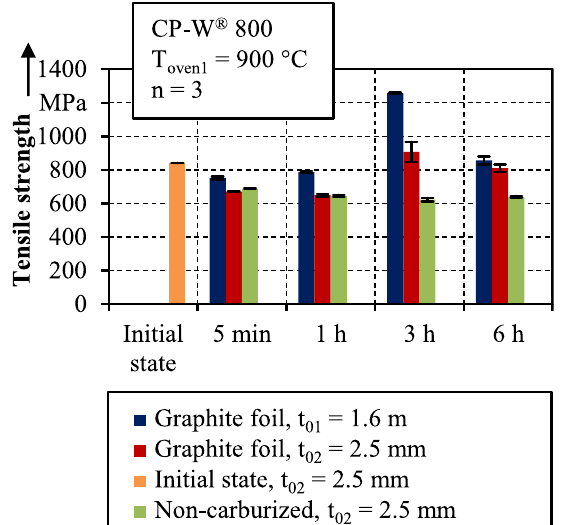
Fig. 2. Used methodology in this work.